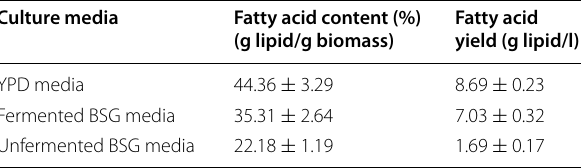
Table 1 Production of fatty acids by R. toruloides in the three different culture media at the end of the fermenta- tion, indicated as mean SD ± Culture media